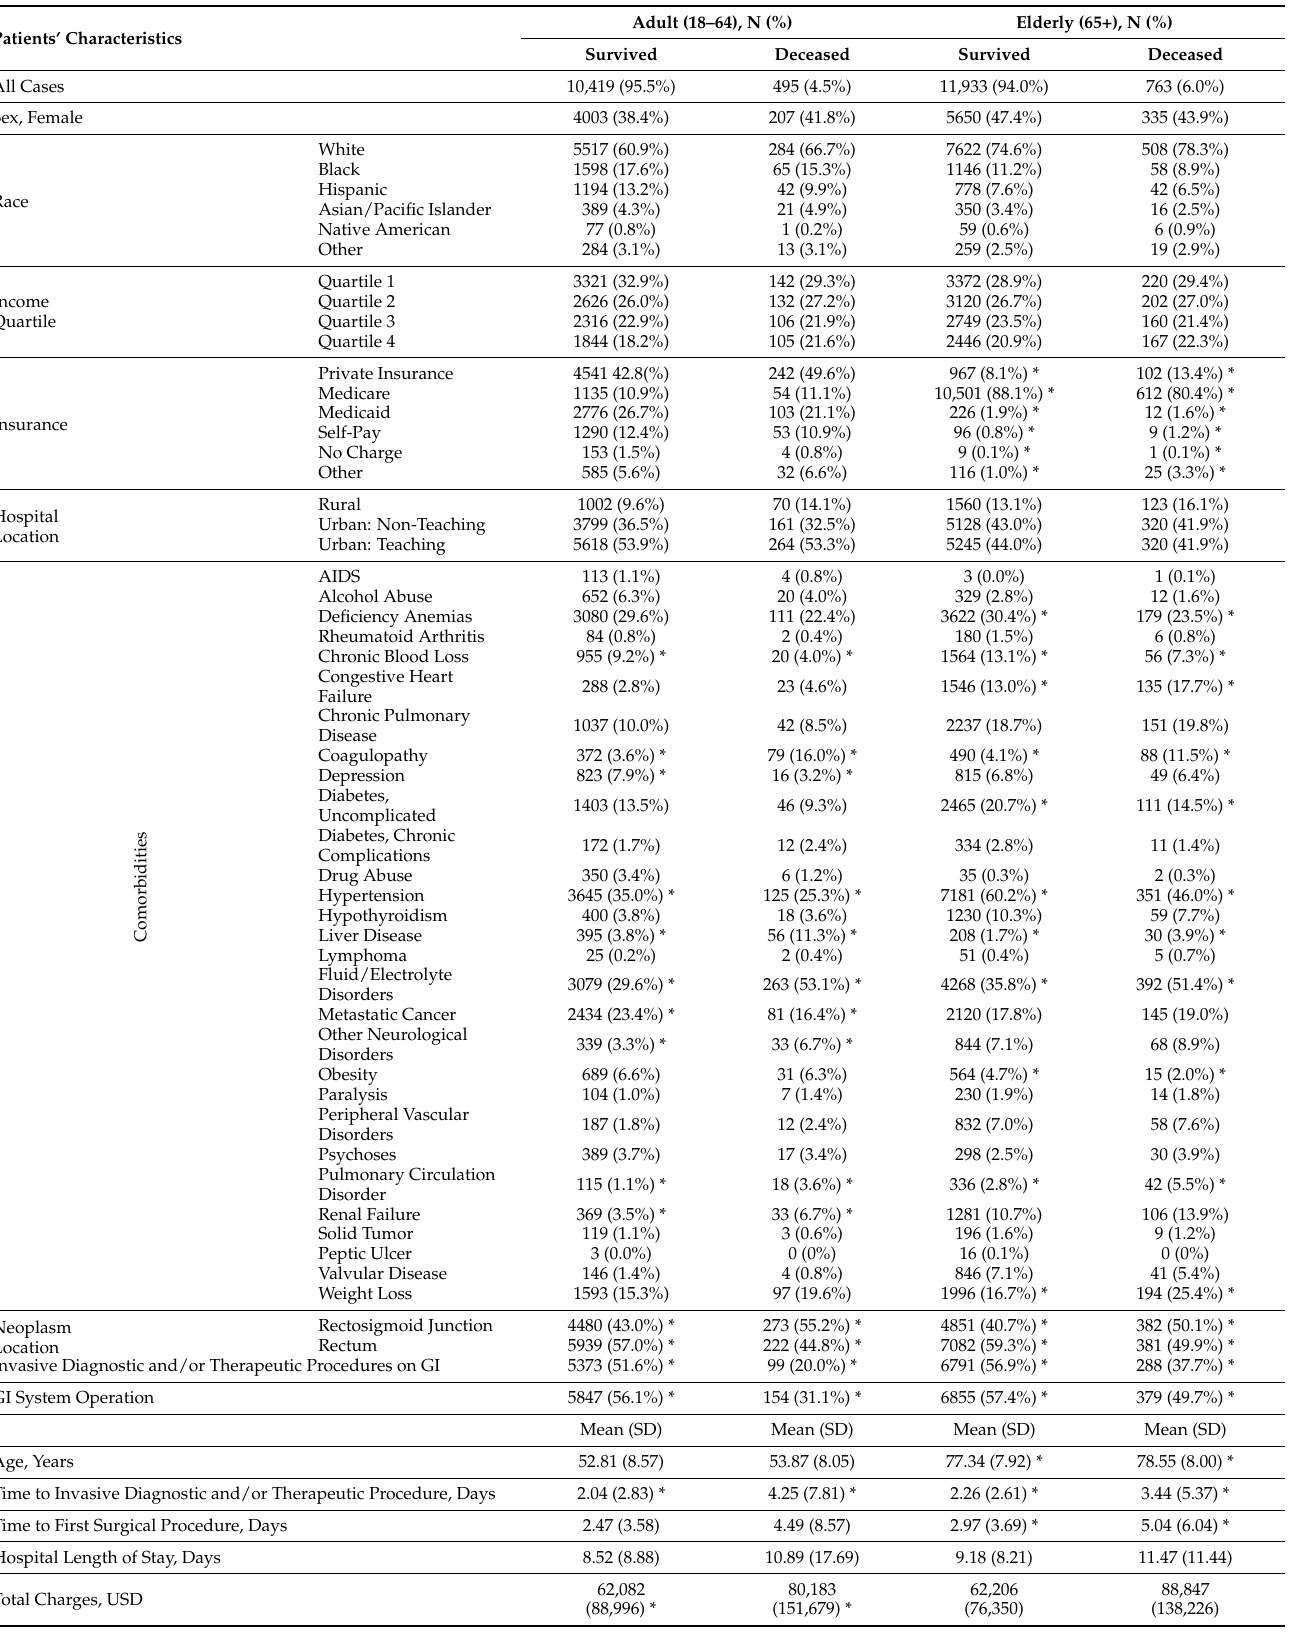
Table 3. Characteristics of emergency admitted patients with the primary diagnosis of malignant neoplasm of rectum or rectosigmoid junction. Data (NIS 2005–2014) were stratified according to outcome categories. * p <